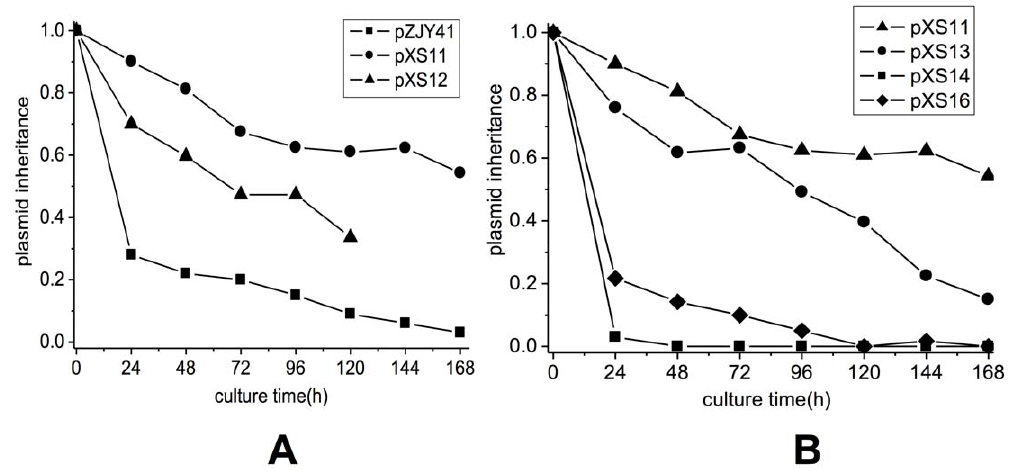
Figure 3. The inheritance stability of the plasmids carrying different fragments of pMF1 in M.xanthus DZ1 in the absence of the selective antibiotic kanamycin (panels A and B). The cultures grown in CTT medium were analyzed for plasmid retention at 24 h intervals until 168 h. The data presented are the average of two independent experiments.